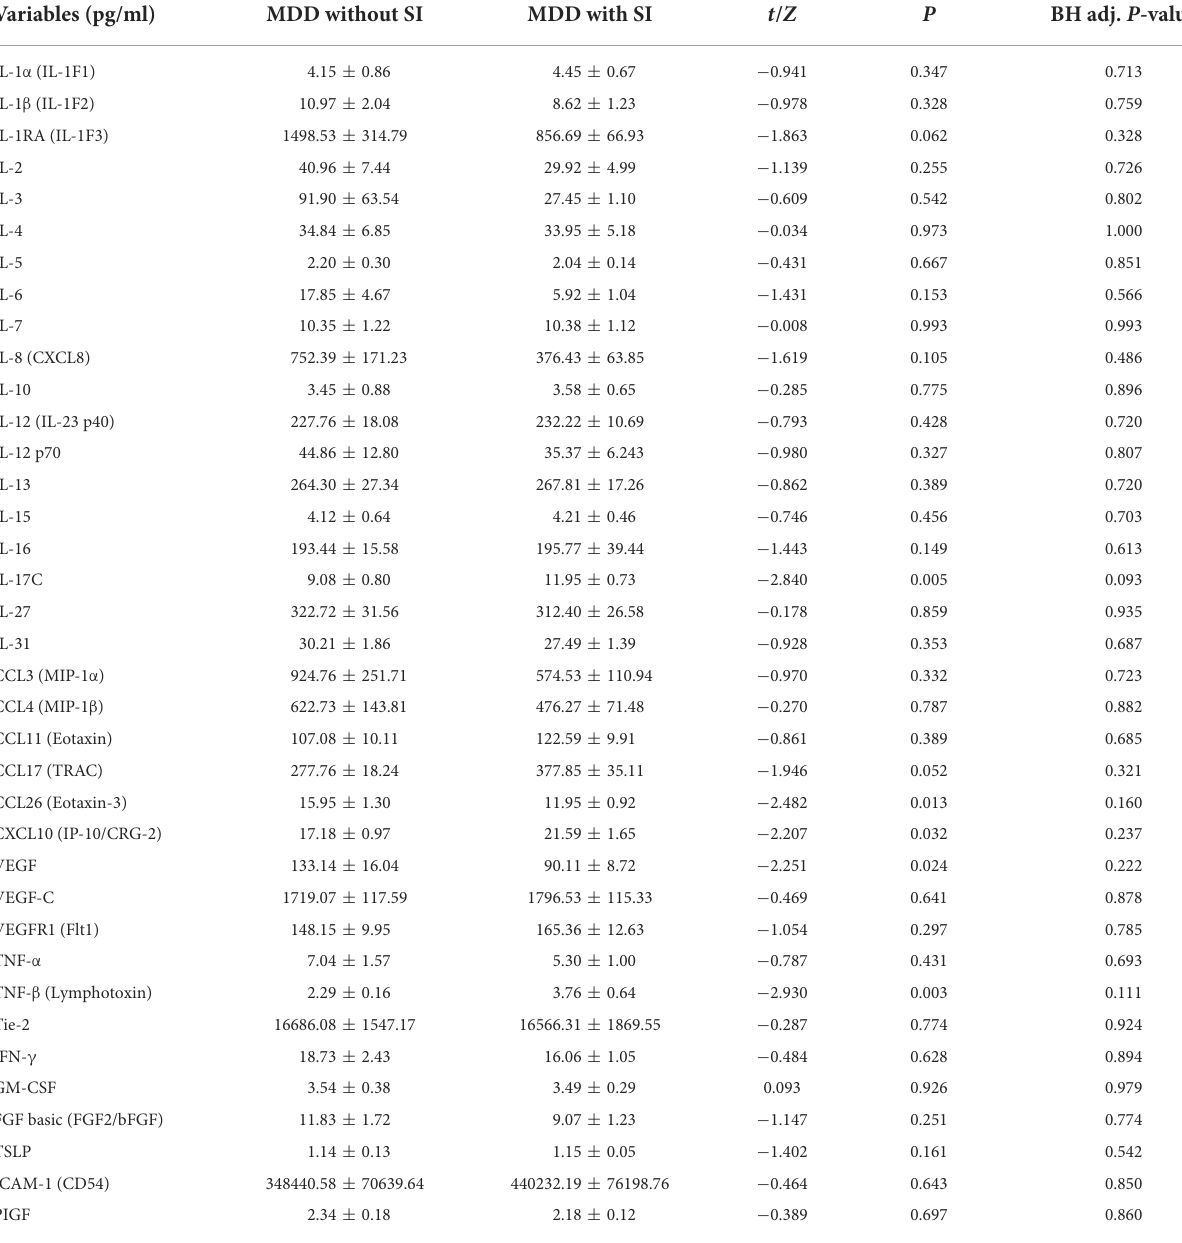
TABLE 2 Comparison of serum cytokines between MDD patients without SI and MDD patients with